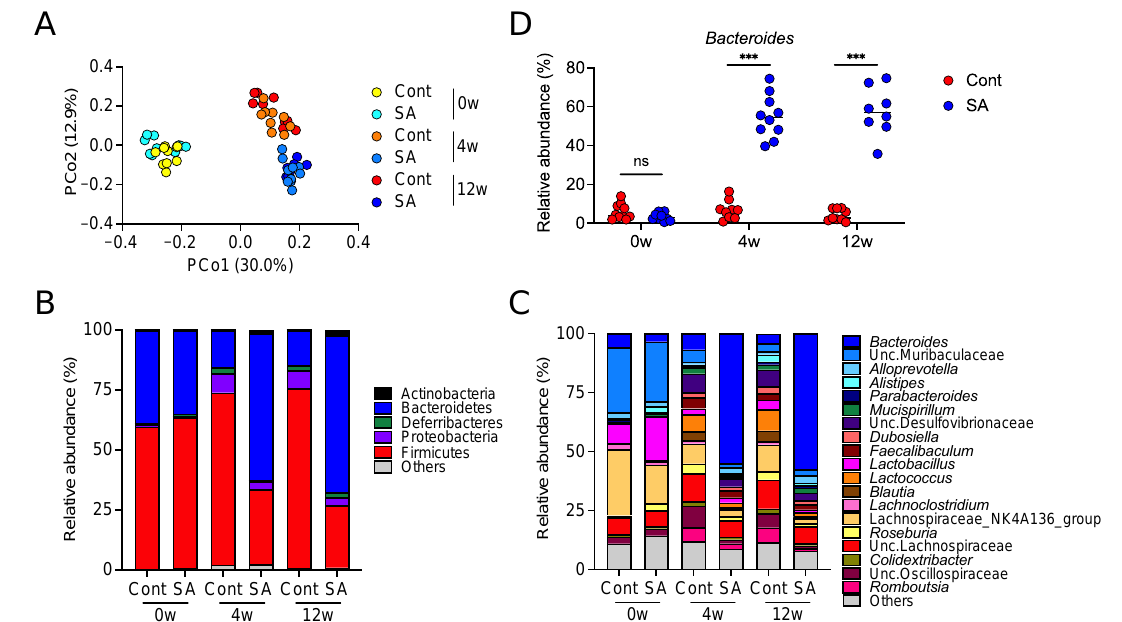
Figure 2. Dietary treatment with sodium alginate (SA) altered the gut microbiota composition of high fat diet (HFD)- fed mice. Mice were fed a HFD supplemented with or without 5% SA for 0, 4, or 12 weeks ( n = 8–10 mice per group). ( A ) Principal component analysis (PCoA) of the microbiome in fecal samples was performed using unweighted UniFrac. ( B , C ) Relative abundance of amplicon sequence variants (ASVs). The different colors correspond to different bacterial phyla ( B ) and genera ( C ), as indicated. ( D ) Relative abundance of Bacteroides in the fecal samples. Each dot represents an individual mouse, and the horizontal bars indicate mean values. Statistical significance was assessed by Welch’s t -test ( D ). *** p < 0.001; n.s., not significant. Cont: HFD diet; SA: HFD diet with 5% sodium